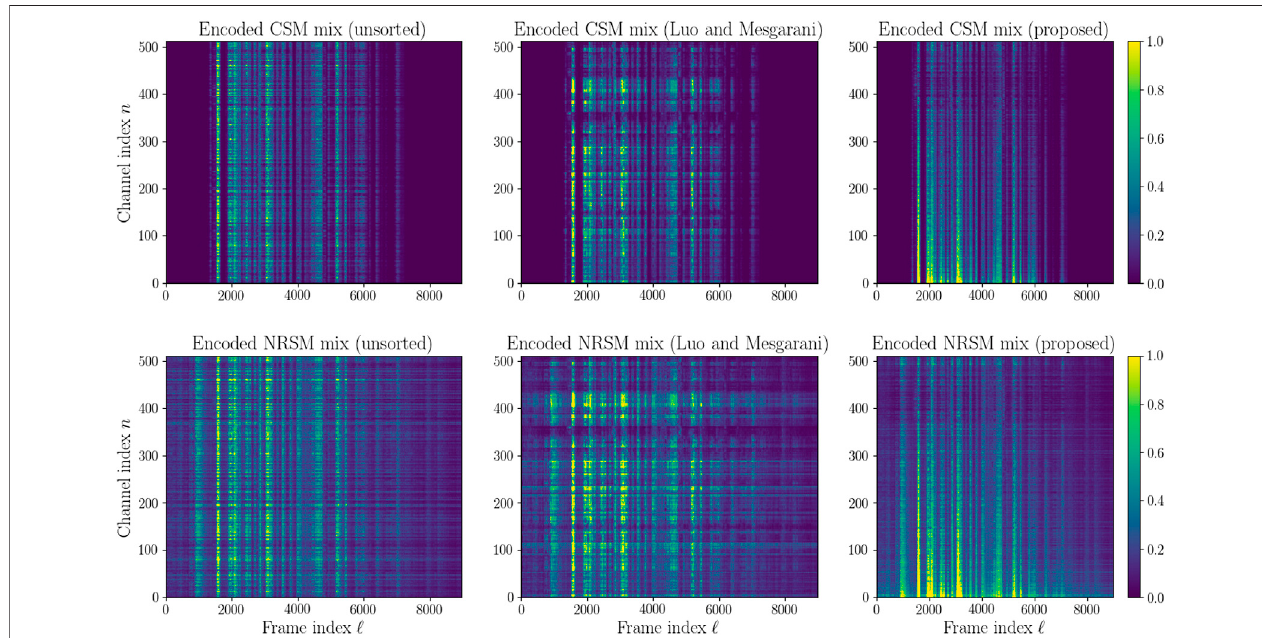
FIGURE 2 | Encoded signal matrix W for clean speech mixtures (CSM) (top) and noisy reverberant speech mixture (NRSM) (bottom). From left to right: unsorted; sorted using Luo and Mesgarani, (2019) ’ s method; sorted using the proposed method in Algorithm 1 .